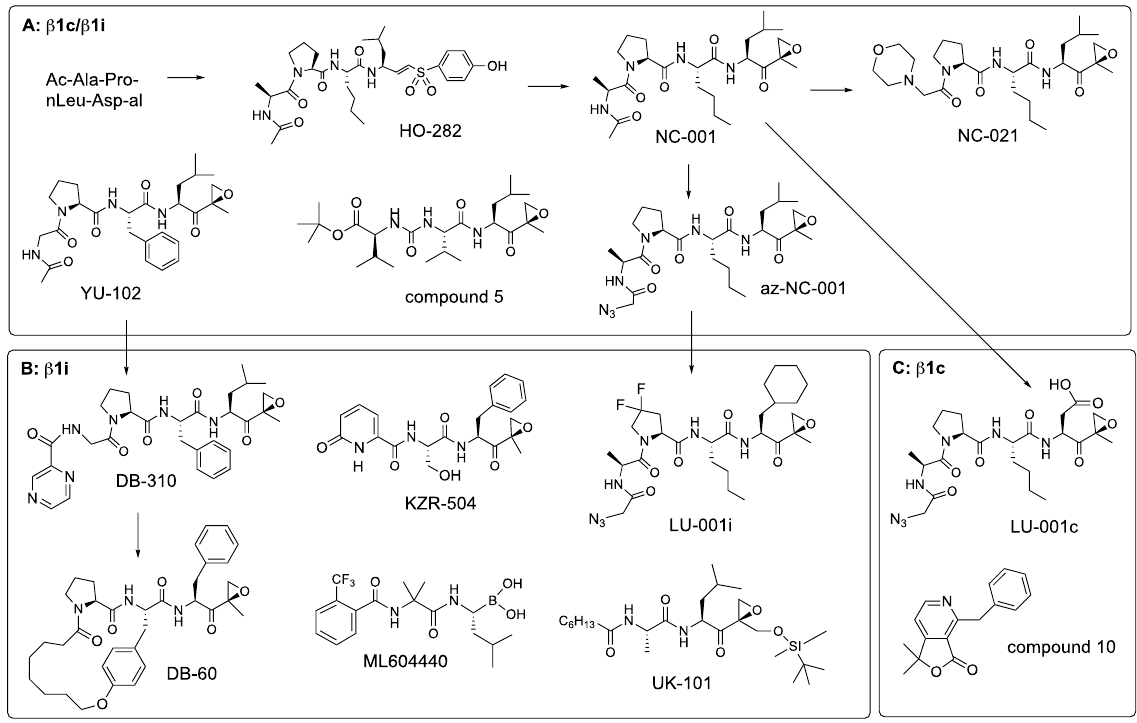
Figure 8. β 1 inhibitors. ( A ). Dual β 1c/ β 1i inhibitors. ( B ). β 1i (LMP2) inhibitors. ( C ). β 1c inhibitors. Arrows show the interrelationship between compounds.